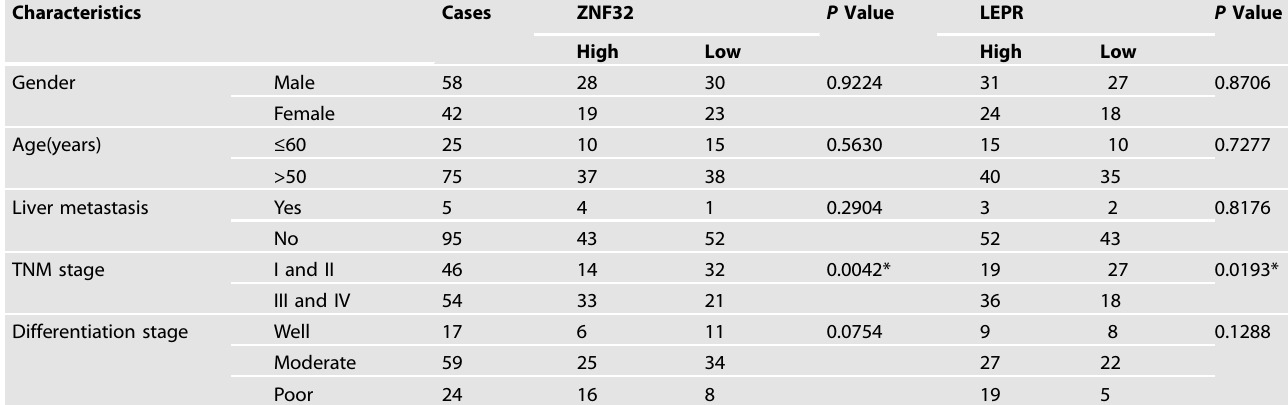
Table 1. The clinicopathological factors of CRC patients.